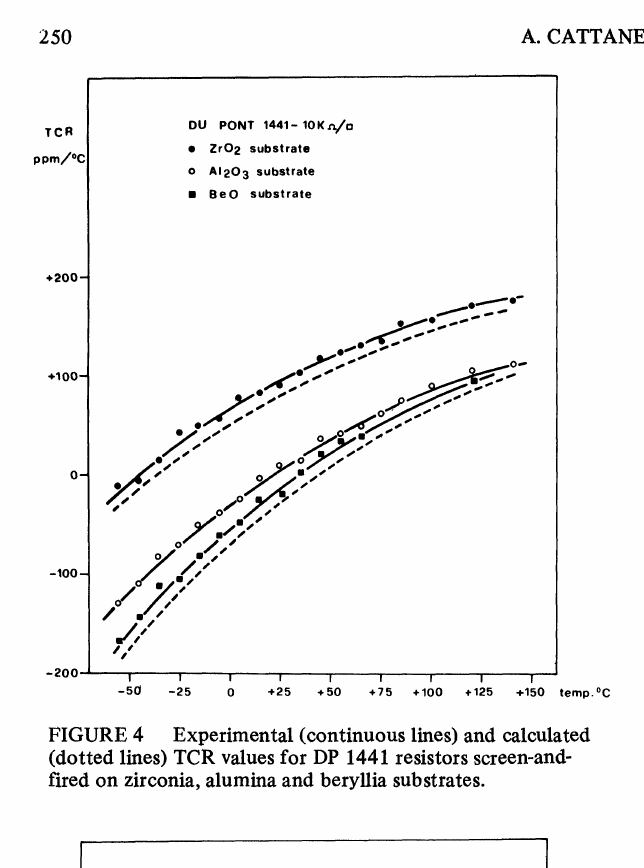
Experimental (continuous lines) and calculated (dotted lines) TCR values for DP 1441 resistors screen-and- fired on zirconia, alumina and beryllia substrates.